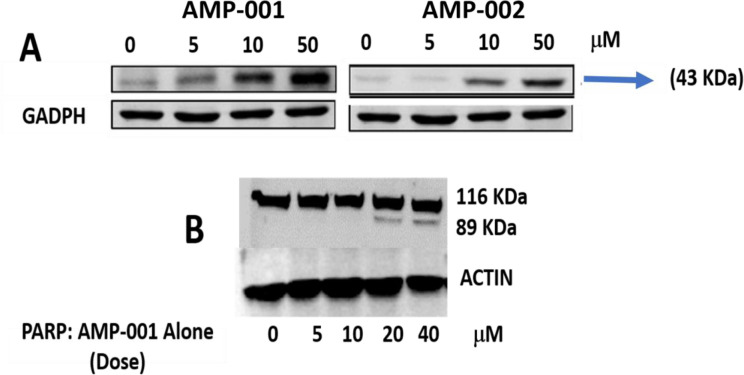
A: Increased expression of CD95 (40 KDa) band in Western Blotting upon treatment of MDA-MB-231 cancer cells by AMP-001 and AMP-002, B) total and cleaved PARP levels by dose dependent treatment of MDA-MB-231 cells by AMP-001. N = 4 P<0.001 for A, p < 0.004 for B, Beta-Actin and GAPDH are standard controls.